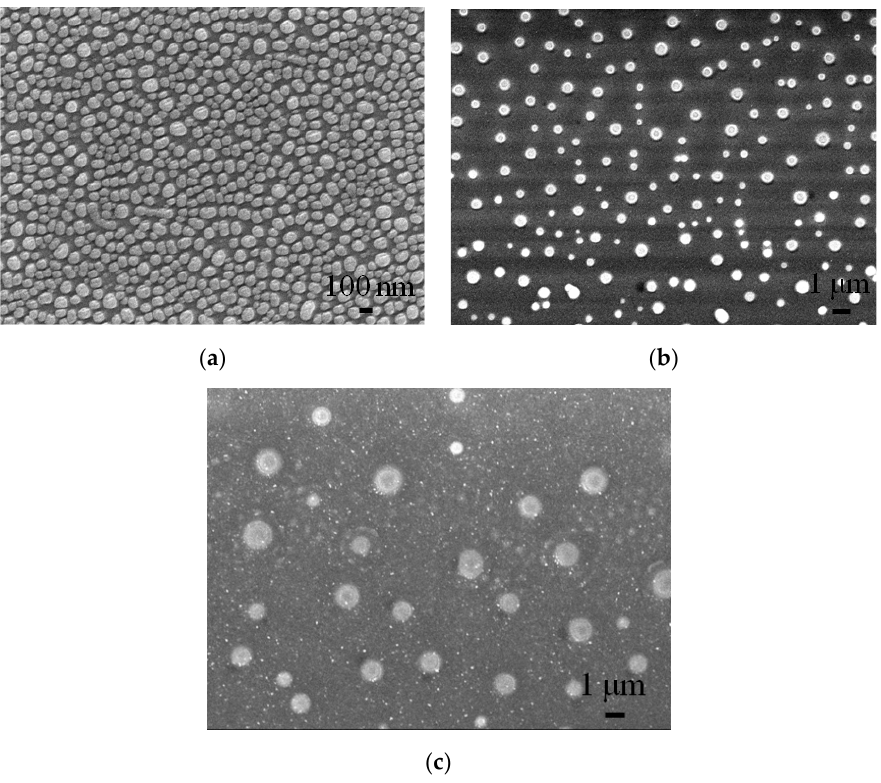
Figure 1. SEM images of Ag particles with a sizes of ( a ) 92 nm, ( b ) 570 nm and ( c ) 1.2 µ m.